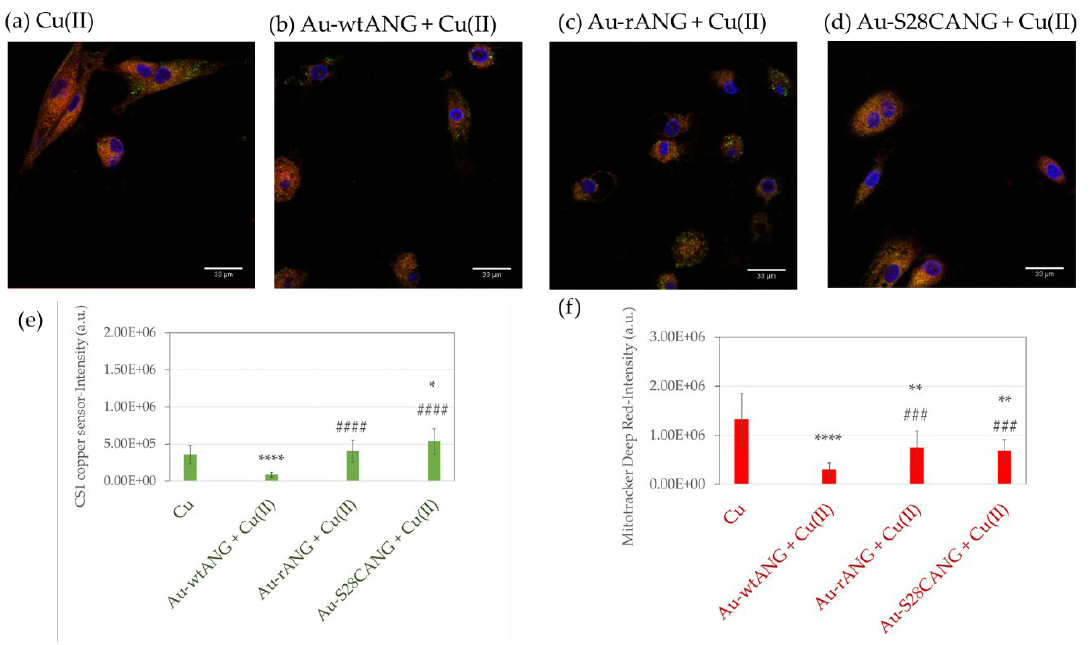
Figure 9. LSM micrographs of HUVECs (in blue, nuclear staining, λ ex/em = 405/425–450 nm; in green, CS1-copper probe, λ ex/em = 543/550–600 nm, in red mitochondrial staining, MitoTracker d.r λ ex/em = 633/650–655 nm) after 2 h of treatment with: ( a ) CuSO 4 (1 × 10 − 7 M); ( b – d ) AuNP-ANG hybrids in the presence of CuSO 4 (1 × 10 − 7 M) (Au-wtANG: 2.77 × 10 6 NP /mL corresponding to [AuNP] = 2.1 × 10 − 10 M; Au-rANG: 2.32 × 10 7 NP /mL corresponding to [AuNP] = 3.1 × 10 − 10 M; Au-S28CANG: 1.96 × 10 6 NP /mL, corresponding to [AuNP] = 2.1 × 10 − 10 M). Scale bar 10 µ m. Intensity value of fluorescence corresponding to the ( e ) CS1 copper probe and ( f ) Mitotracker deep red staining. Bars represent means ± SEM of at least 3 experiments; (*) = p < 0.05, (**) = p<0.01, (****) = p < 0.0001 vs. Cu; (###) = p < 0.01, (####) = p < 0.0001 vs. Au-wtANG (Student’s T-test).